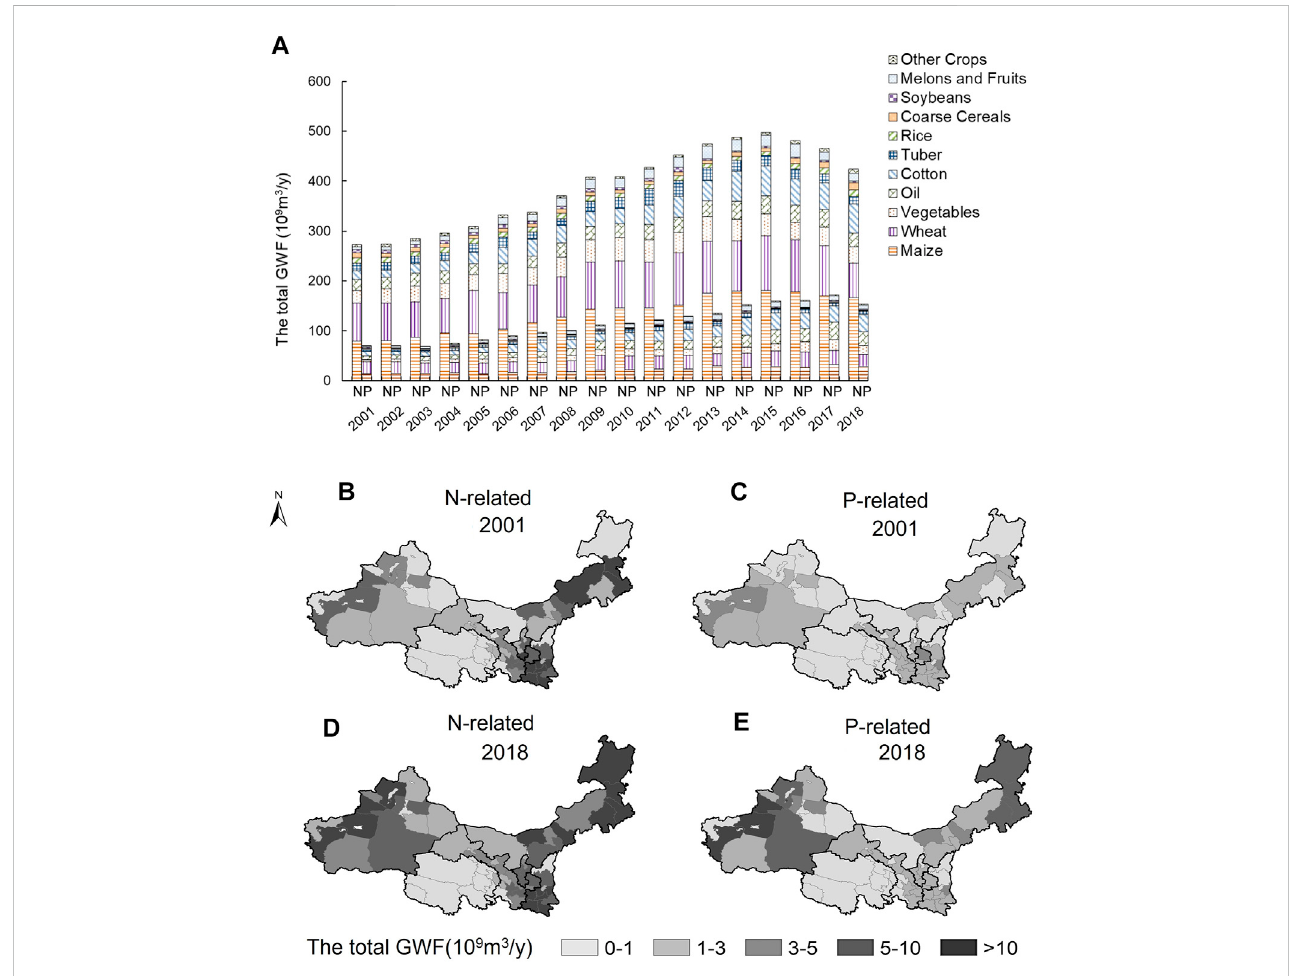
FIGURE 2 Spatiotemporal evolution of N- and P-related GWF in West China. (A) The interannual variation in the total GWF of crop production from 2001 to 2018; (B – E) the spatial distribution map of the total GWF of crop production in 2001 and